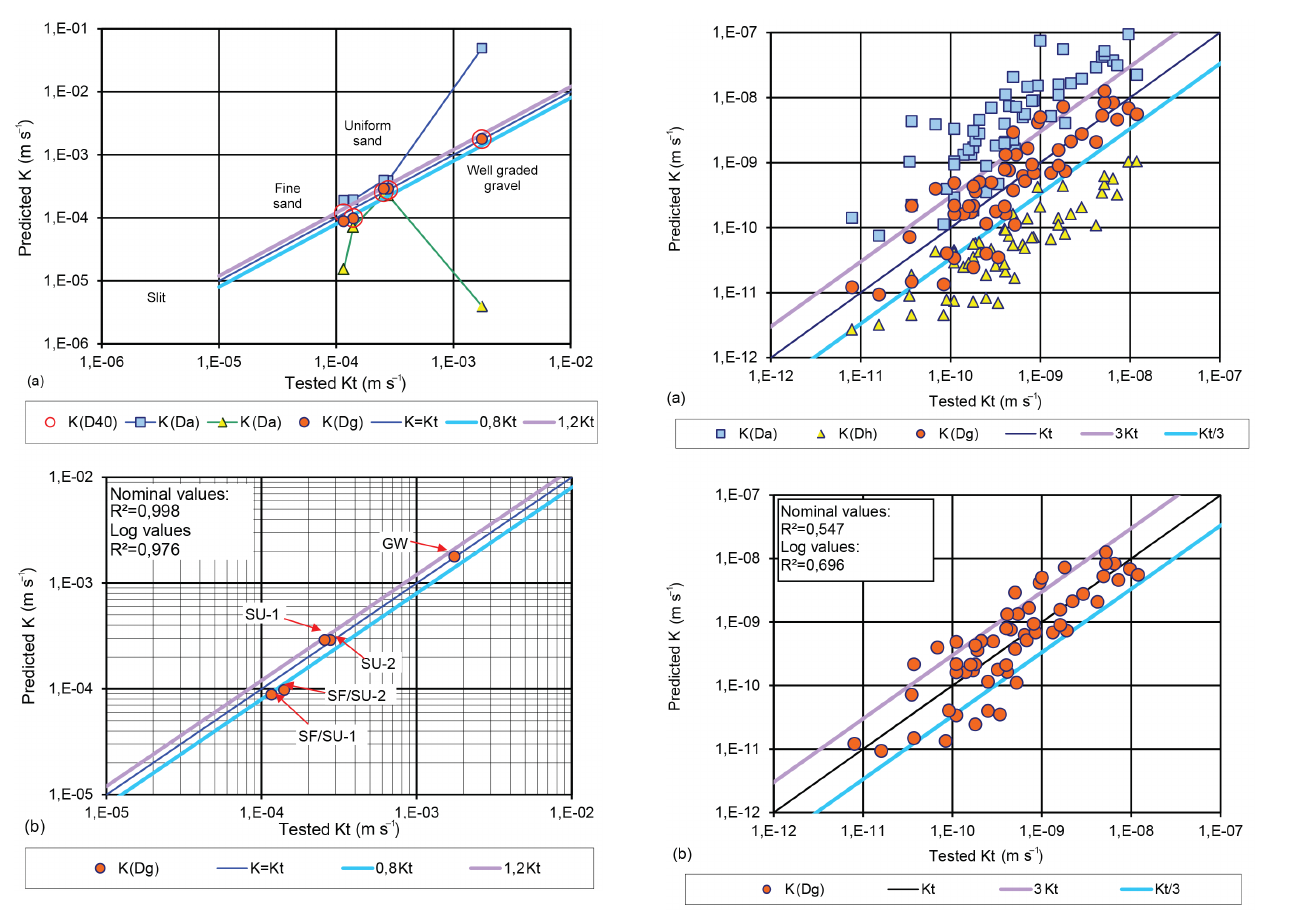
Figure 12. Graphical correlation between predicted K and tested K t for silt and clay deposits. (a) Difference between arithmetic, ge- ometric and harmonic mean grain size. (b) Result of correlation be- tween predicted K(D g ) and tested K t